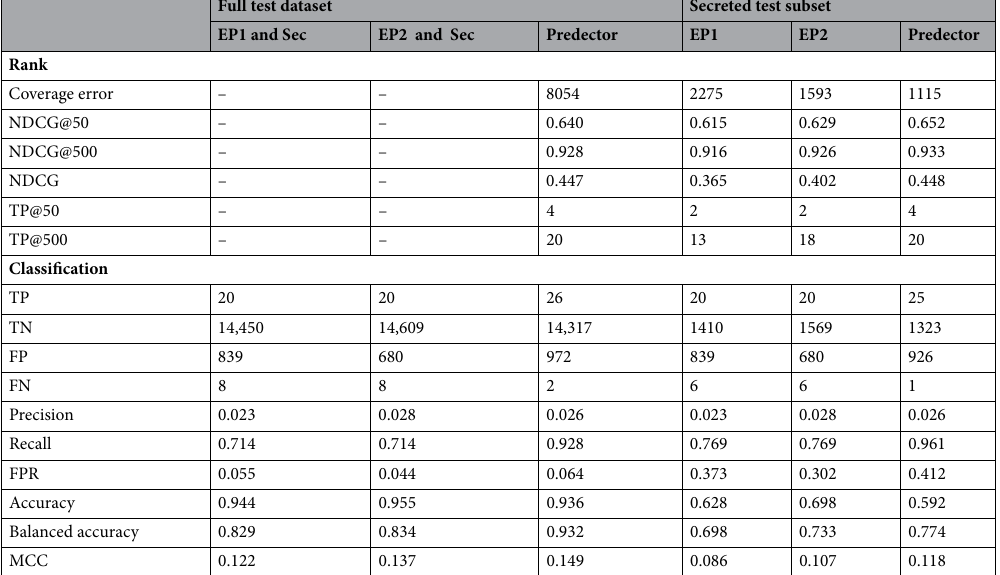
Table 1. Effector prediction and ranking statistics for Predector and a combined classifier based on EffectorP and secretion prediction on the test dataset. Test datasets here do not contain any effector homologue sequences. Note that EffectorP is not optimised for ranking tasks and Predector is not optimised for classification. These scores are shown merely for comparison and not necessarily as an endorsement of how they should be used. Coverage error is the index of the last known effector in the test dataset. NDGC is a measure of how often effectors are placed ahead of unlabelled samples in the list sorted by score, penalising incorrect orderings more highly near the top of the list. NDGC@N is the same statistic but only for the top N items in the sorted list. TP, TN, FP, FN are the number of true positives, true negatives, false positives, and false negatives for the classification task, respectively. TP@N indicates the number of known effectors in the top ranked N proteins. Precision indicates how many of the predicted effectors are false positives (unlabelled